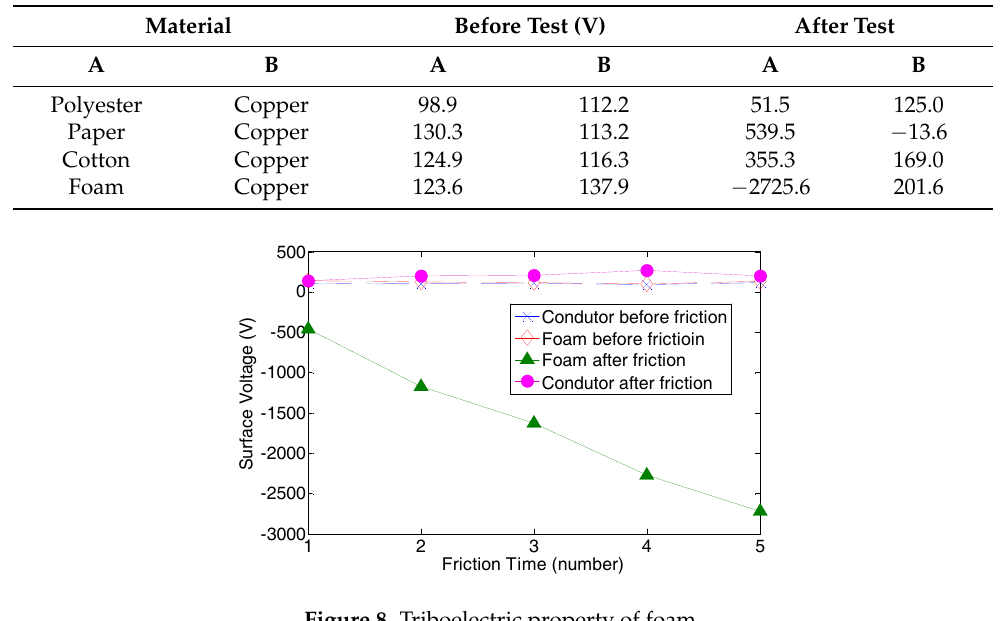
n LEDs Figure 9. The Power Management Circuit for Powering a LED series. ( a ) ( b ) Figure 10. ( a ) A single WearETE powers 52 LEDs at each pulse. ( b ) A larger version of WearETE can power 190 LEDs. 3.2. System Performance